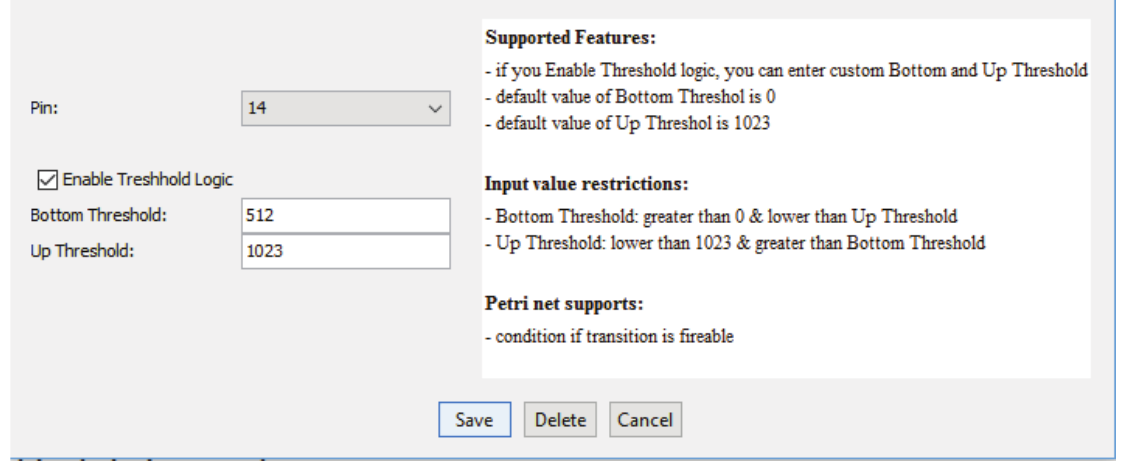
Figure 6. PN2ARDUINO—Analog input.